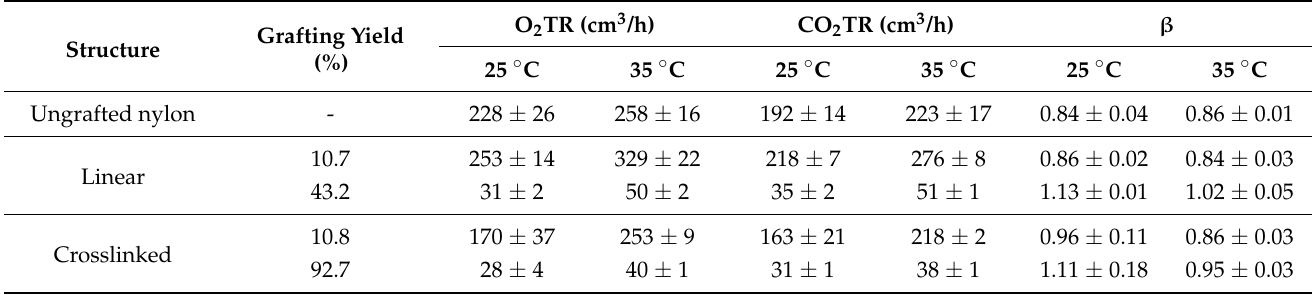
Table 3. Gas transmission rates and permselectivity of PNIPAm-grafted nylon membranes.